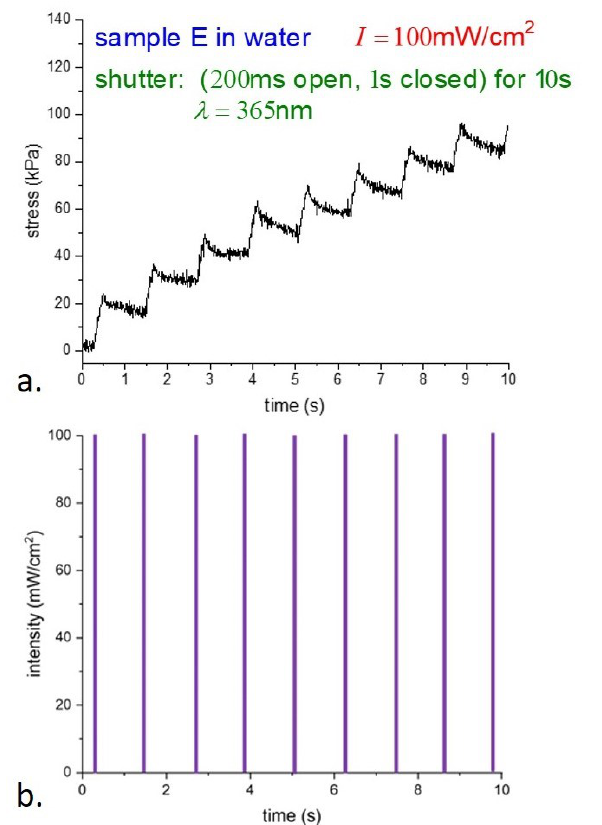
Figure 7. ( a ) Photostress showing leading edges of ( b ) light